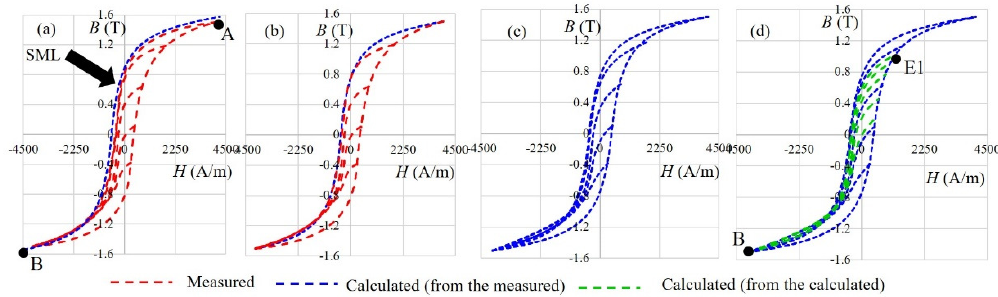
Figure 8. Steps of the hysteresis modeling procedure: ( a ) Determination of P 1 to P 6 for SML; ( b ) Adjustment of P 1 and P 6 for SML; ( c ) Determination of analytical expressions for all measured curves; ( d ) Calculation of the required curves.